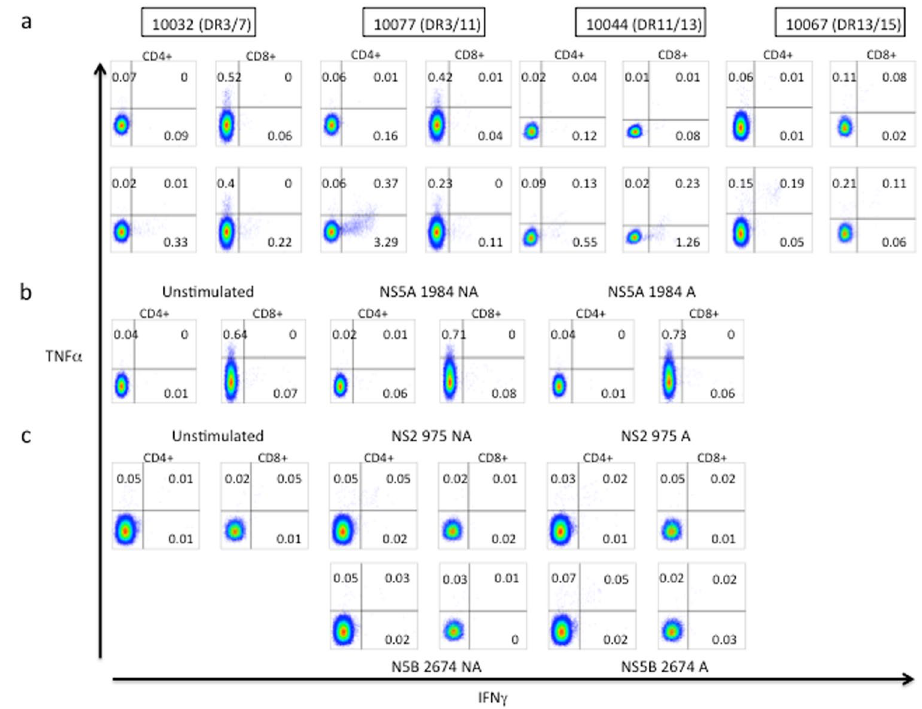
Figure 2. Intracellular cytokine staining indicates HCV-specific CD4 + T cell IFN γ response to peptide pool containing putative HLA-class II restricted epitopes. ( a ) TNF α and/or IFN γ production in antigen-specific CD4 + and CD8 + T cells. Top panel unstimulated and bottom panel peptide pool. ( b ) and ( c ) Specific peptide responses for subject 10032 and 10067,